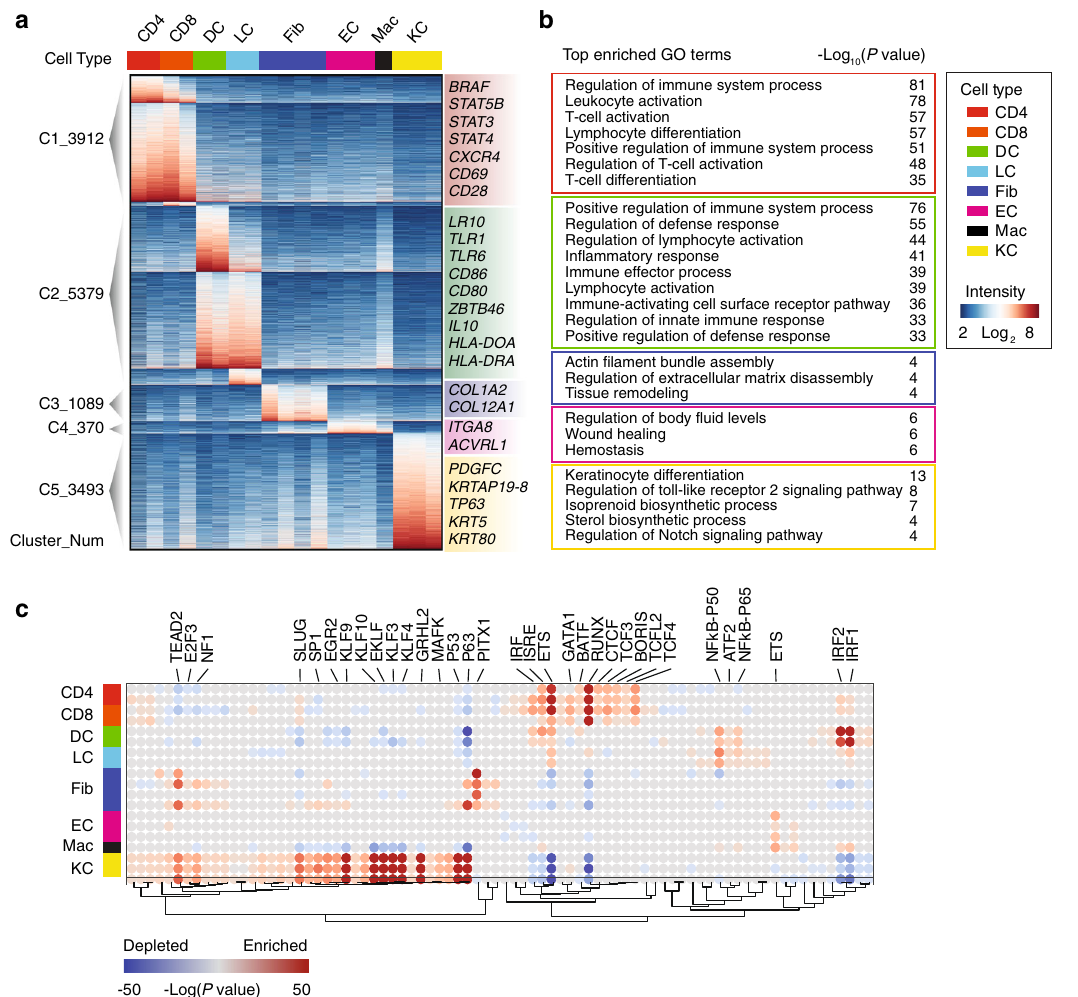
Fig. 2 Cell type-speci fi c chromatin accessibility in a skin biopsy from healthy donors. ( a ) Heatmap of the normalized ATAC-seq intensities of cell type- speci fi c peaks from healthy donors. Each row is a peak, and each column is a sample, with color-coded cell types (top panel). Clusters shown in the sidebar represent cell-type-speci fi c peaks of CD4 (CD4 + T cells) and CD8 (CD8 + T cells) (C1), DC (dendritic cells) and LC (Langerhans cells) (C2), Fib ( fi broblasts) (C3), EC (endotheliocytes) and Mac (macrophages) (C4), and KC (keratinocytes) (C5) respectively. Functional marker genes in each cluster were shown on the right. Source data are provided as a Source Data fi le. ( b ) Top enriched GO (Gene Ontology) terms of peaks in each cluster. P values (Binom Raw P value) were calculated using the binomial statistic test in GREAT. Source data are provided as a Source Data fi le. ( c ) Enrichment of known transcription factor (TF) motifs in cell type-speci fi c accessible elements for all normal samples. Each row is a TF motif and each column is a sample. The color bar represents the signi fi cance of enrichment estimated from Genomica, where red indicates enriched and blue depleted. Source data are provided as a Source Data fi